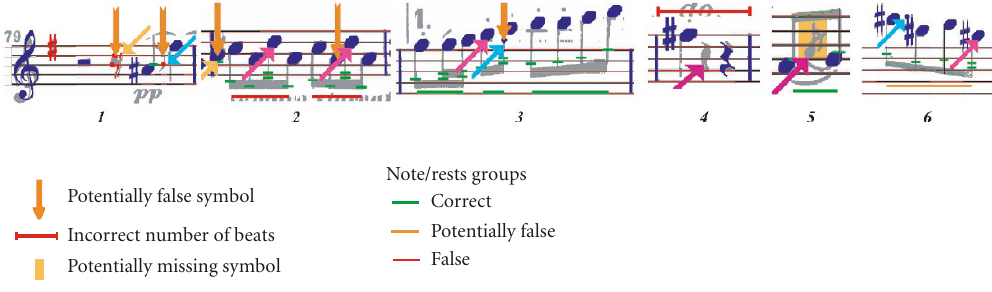
Figure 20: Potential error